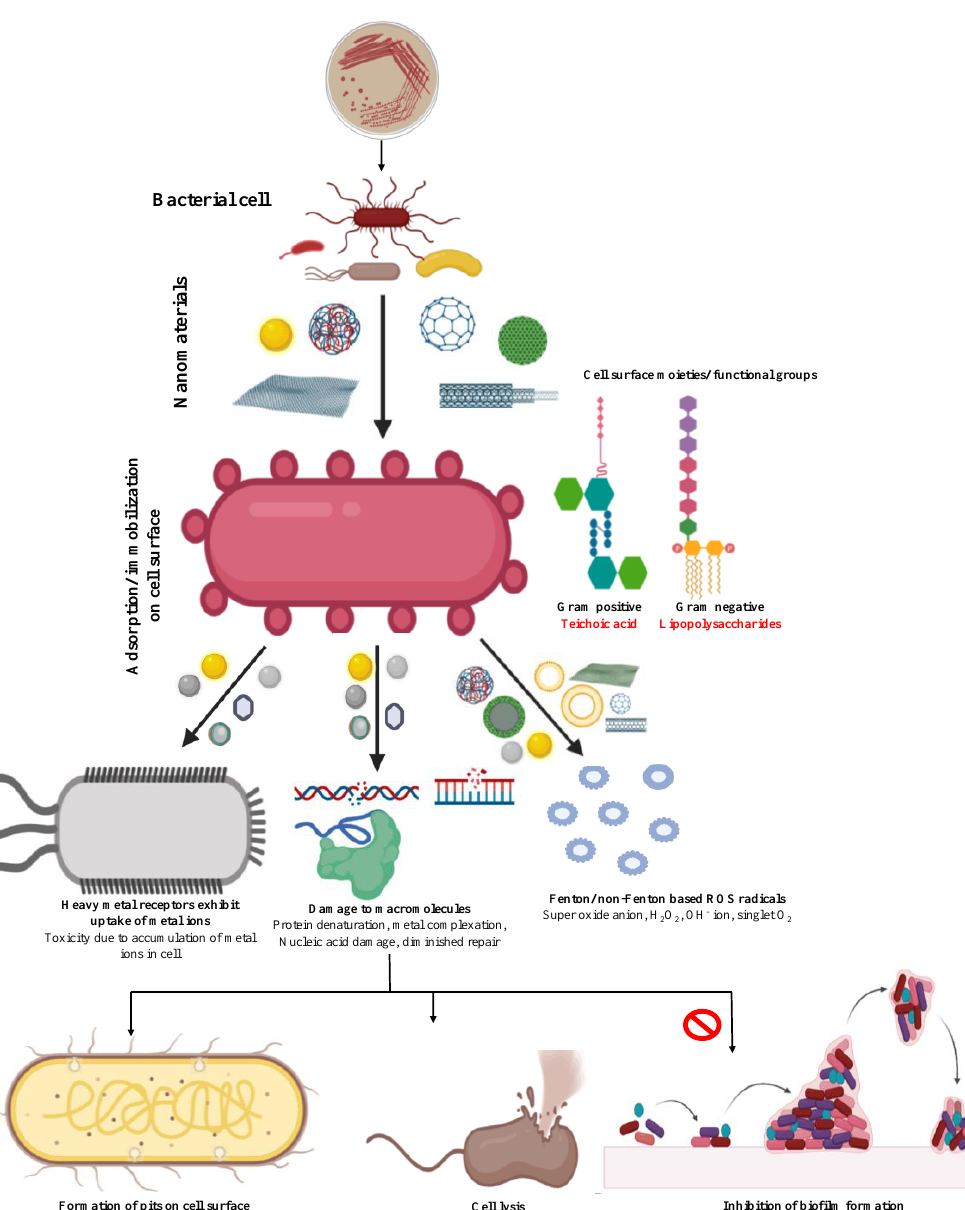
Figure 2. Mechanisms governing the antibacterial potential of different types of nanomaterials.